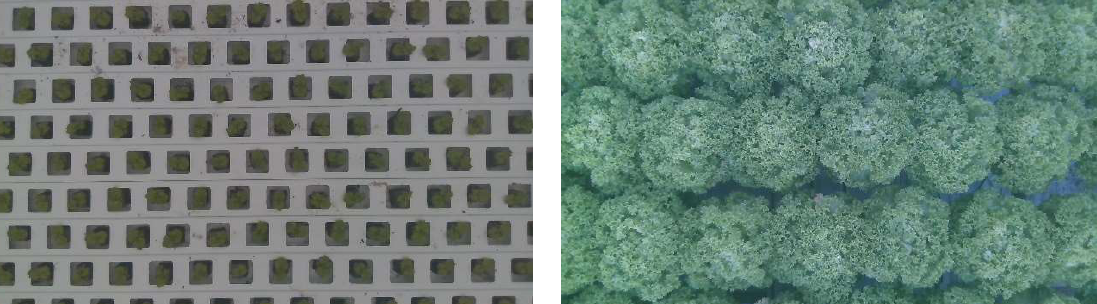
Figure 4. Two example images of RealSense D415 from the day of planting ( left ) and the day of harvest ( right ). On the day of harvest, plants were sampled from the field of view of the camera and were destructively measured for height, diameter, fresh weight, dry weight, and quality.